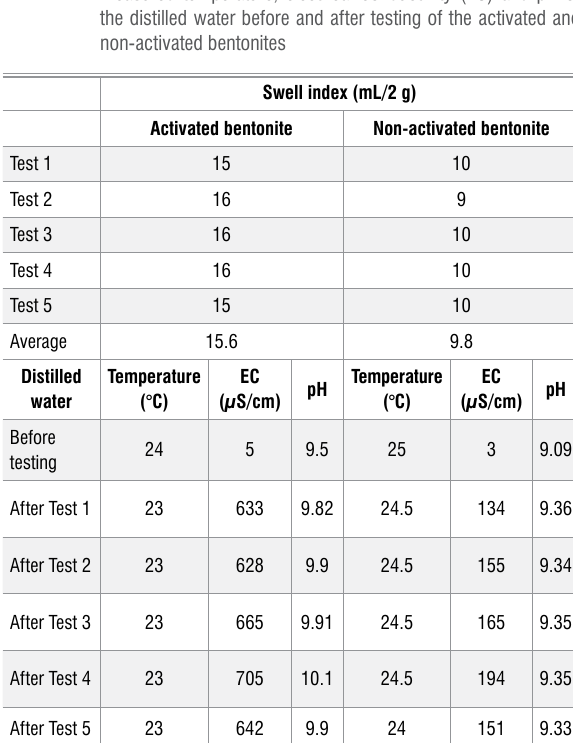
Results from the swell index tests of the activated and non-